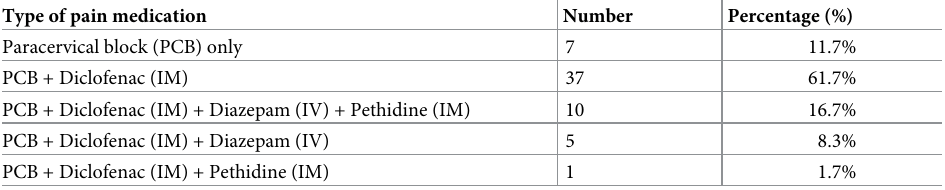
Table 2. Pain medication used during surgical abortions.